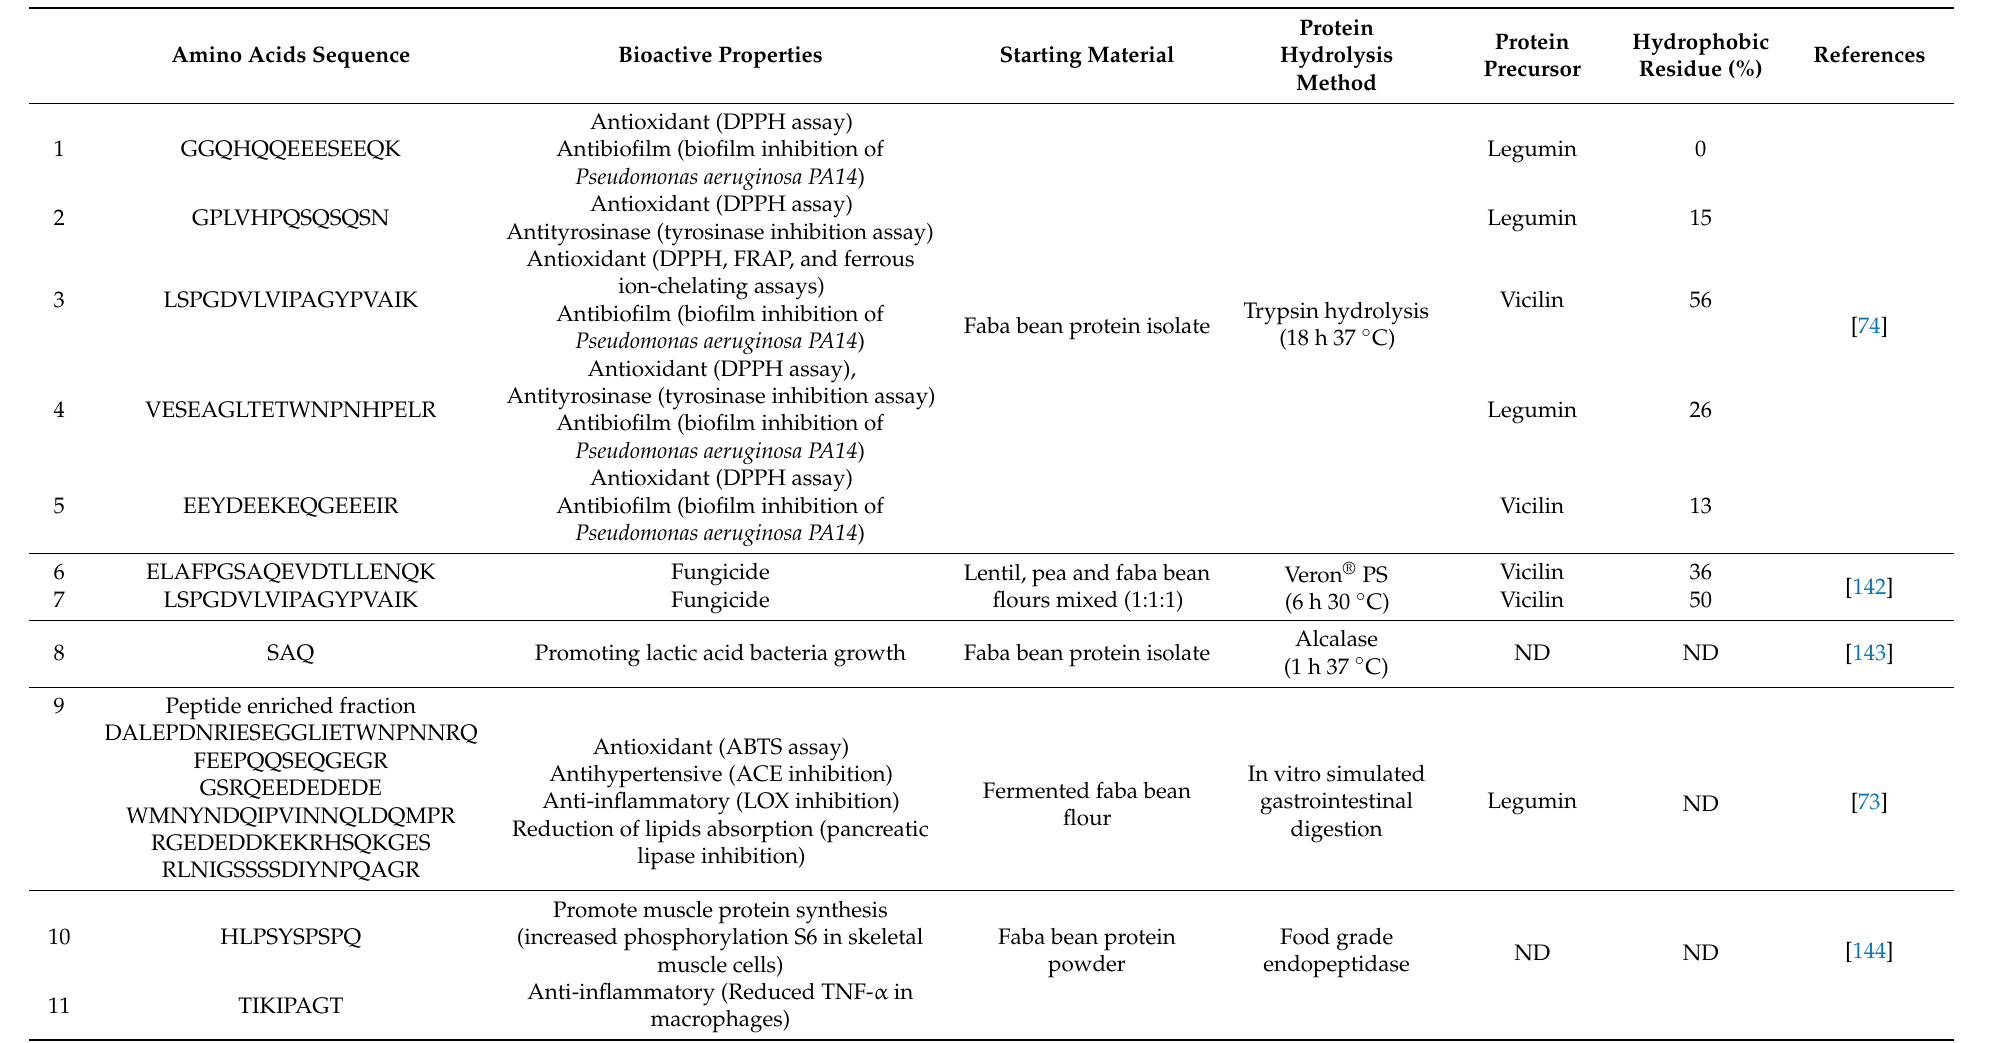
Table 3. Bioactive peptides isolated from faba bean protein